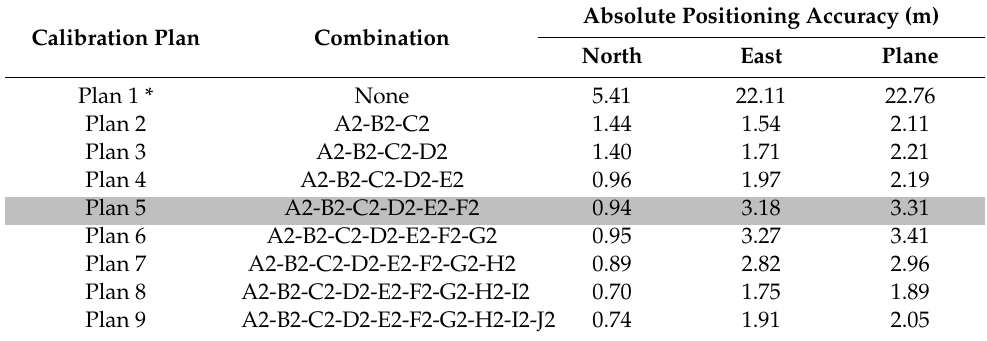
Table 7. Comparison of absolute positioning accuracy of Validation Group B before and after compensating for geometric calibration parameters.